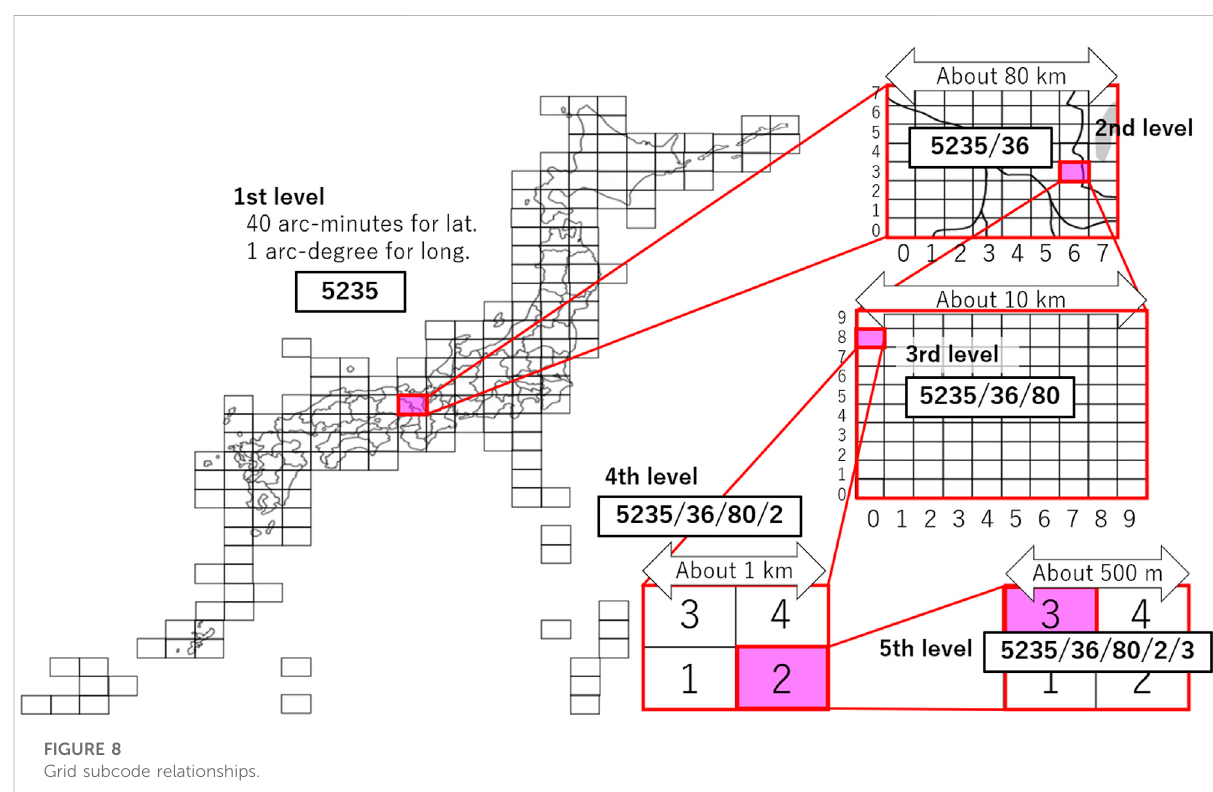
FIGURE 8 Grid subcode